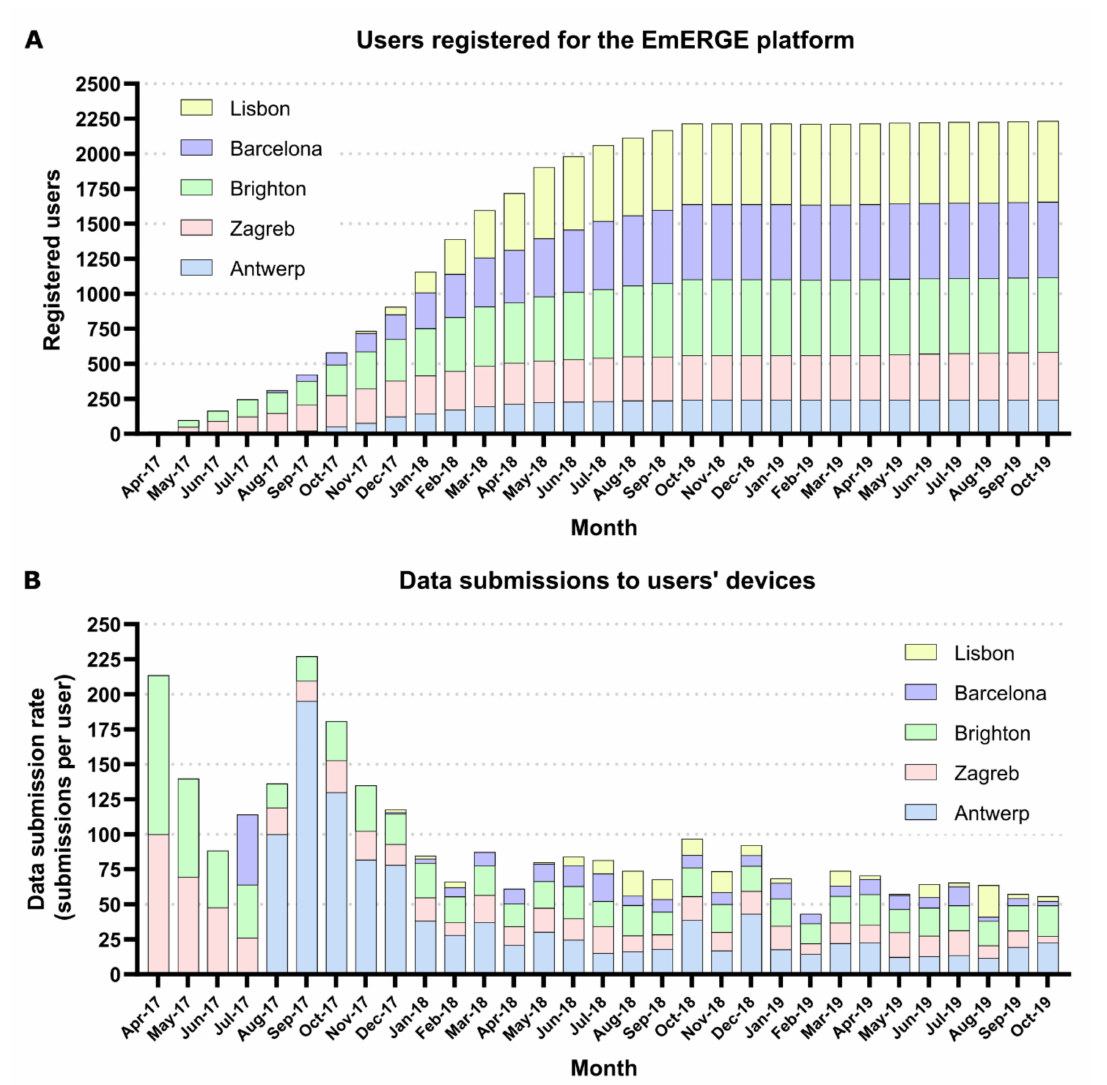
Figure 3. ( A ) Evolution of the number of patients registered for the EmERGE, and ( B ) data submissions to users’ devices at each clinical site during the course of the cohort study.